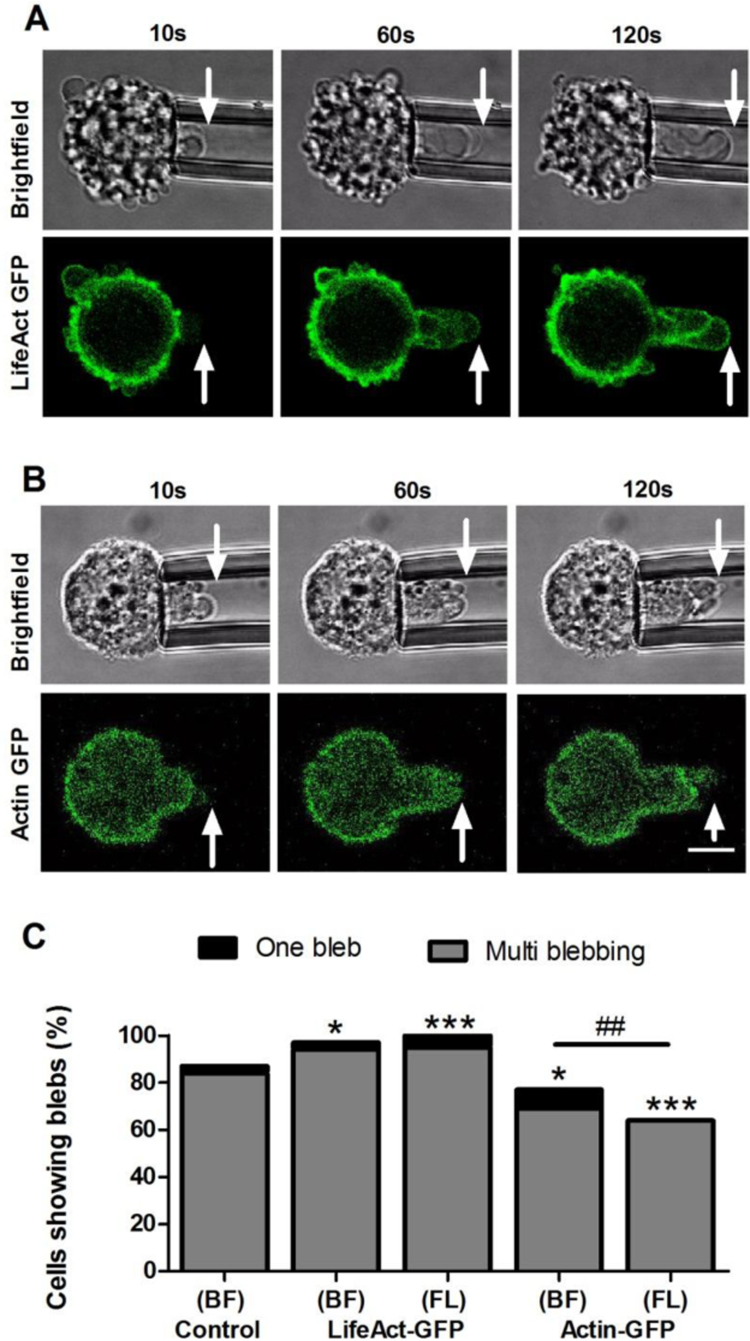
LifeAct-GFP provides clear visualisation of actin deformation, remodelling and bleb formation compared to actin-GFP. Brightfield and confocal fluorescence images of actin dynamics during micropipette aspiration for two representative hMSCs expressing LifeAct-GFP (A) or actin-GFP (B). Images taken at 10, 60 and 120 s after the application of a 0.76 kPa aspiration pressure. White arrows indicate the leading edge of the cell aspirated inside the micropipette based on brightfield images. Scale bar represents 10 µm. (C) Histograms showing the percentage of cells exhibiting membrane blebs. Data presented from two independent experiments, n=67 (control), n=38 (LifeAct-GFP) and n=39 (Actin-GFP). Statistical analyses using the Chi-squared test are indicated relative to non-transfected (BF) control (*: p<0.05, ***: p<0.001) and between percentages estimated from brightfield (BF) and fluorescence (FL) microscopy (##: p<0.01).